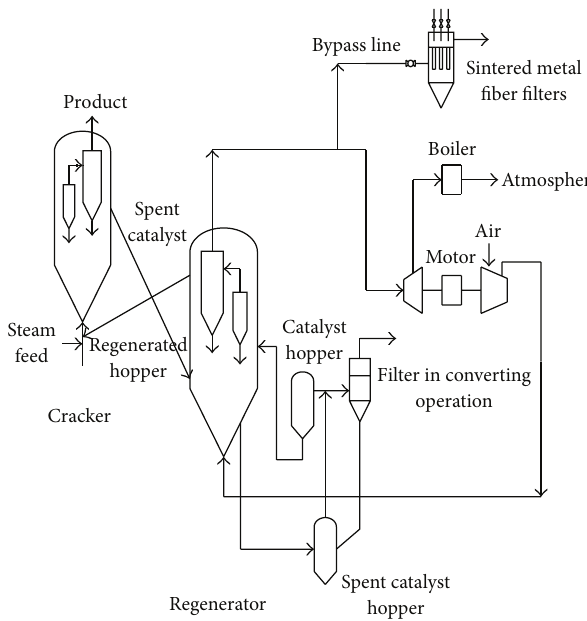
Figure 1: A typical layout of a FCC unit and the location of hot gas filtration facility.